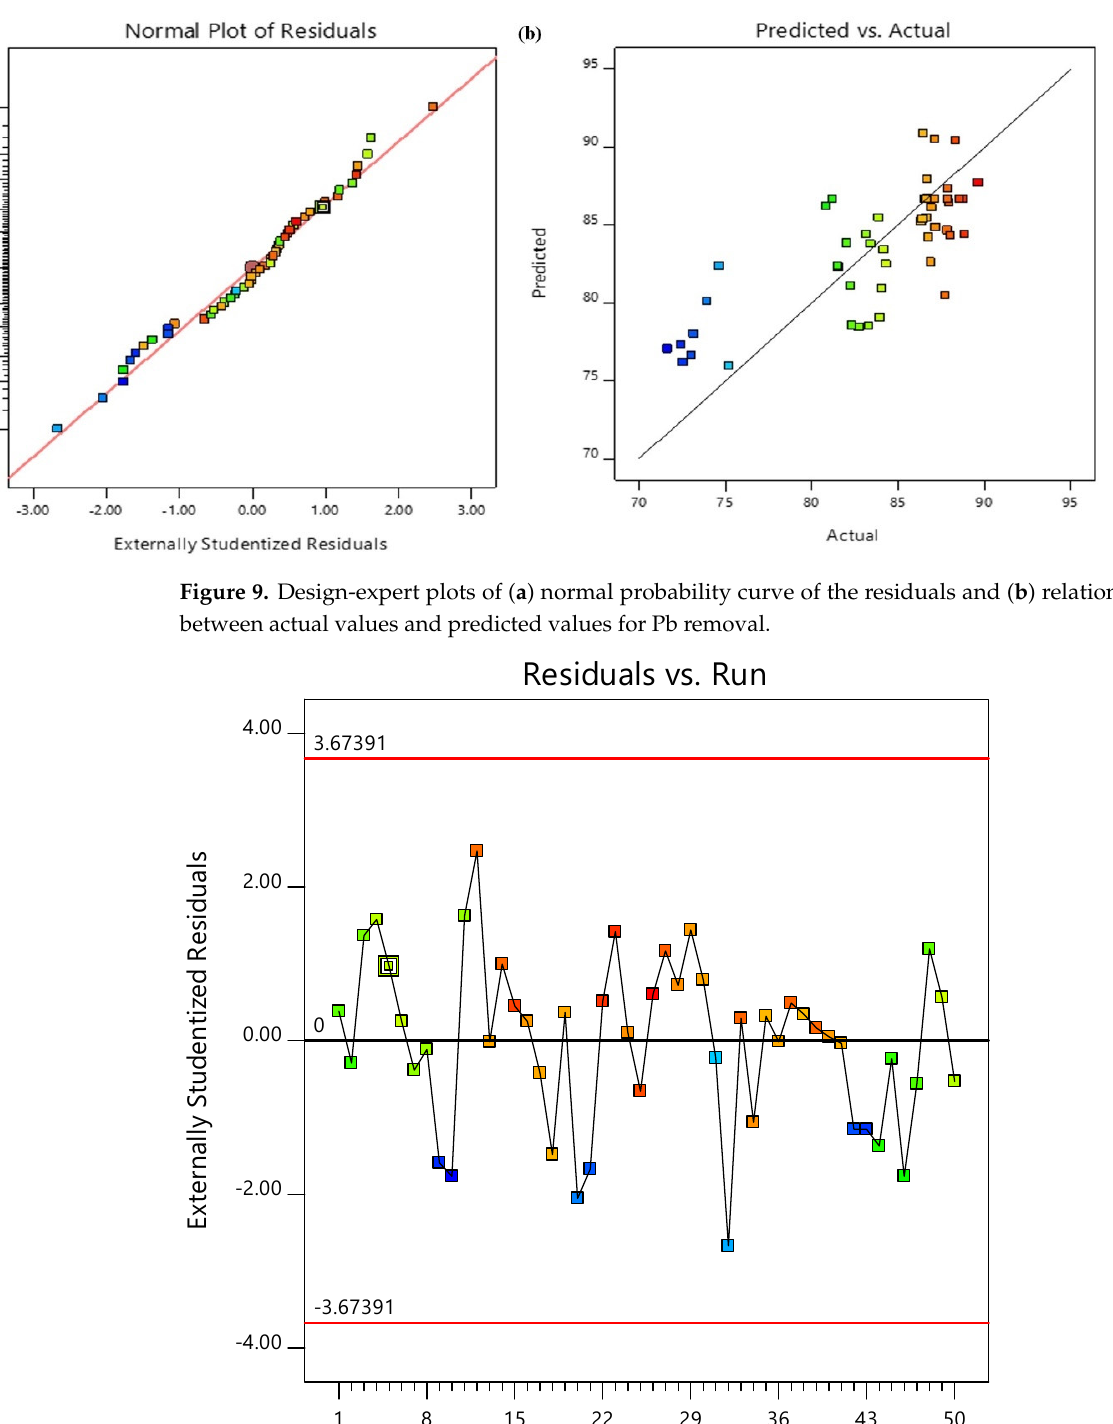
Figure 10. Probability plot of externally studentized residuals vs. Run Number for Pb removal.